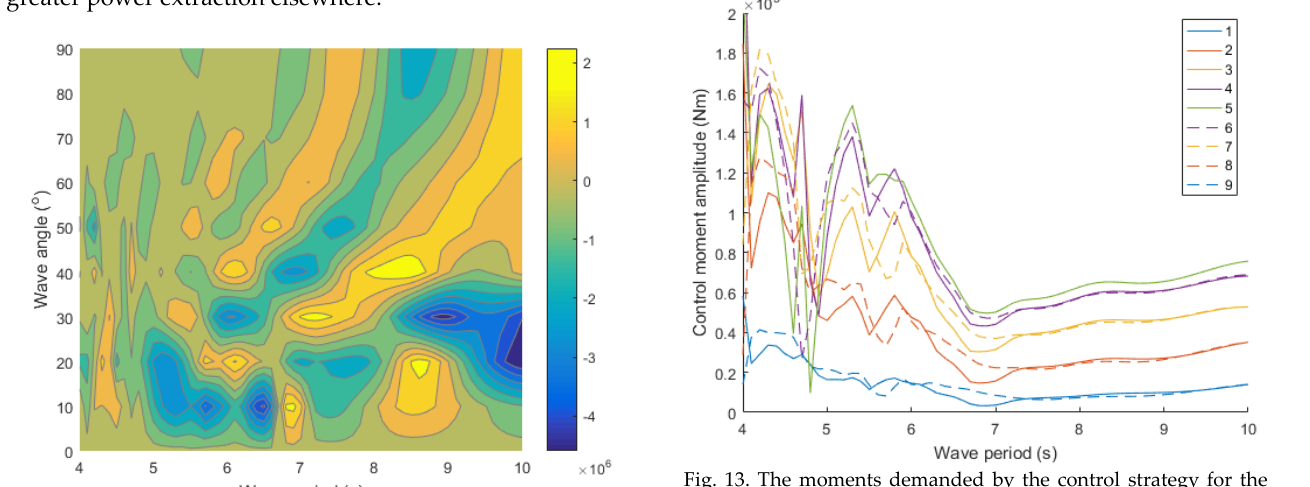
Fig. 13. The moments demanded by the control strategy for the joint roll degrees of freedom tend to be larger for joints closer to the centre of the spine, though this is somewhat dependent on wave period. Joints are numbered from fore to aft (see legend).